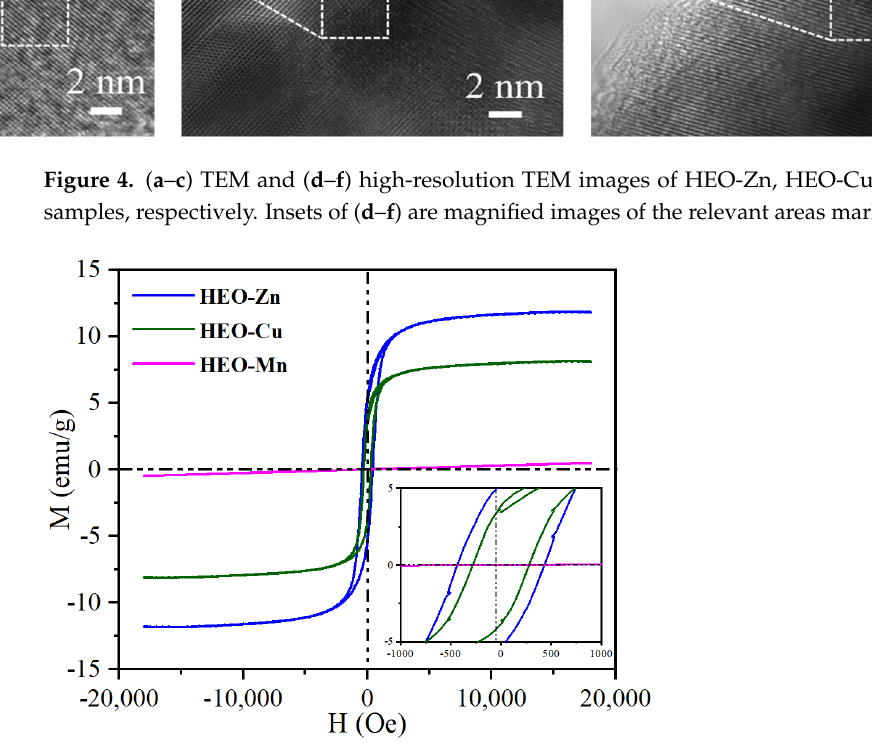
Figure 5. The hysteresis loops of the as-obtained samples of HEO-Zn, HEO-Cu, and HEO-Mn. Table 1. The magnetic properties of Ms, Hc, and Br of HEO-Zn, HEO-Cu, and HEO-Mn.